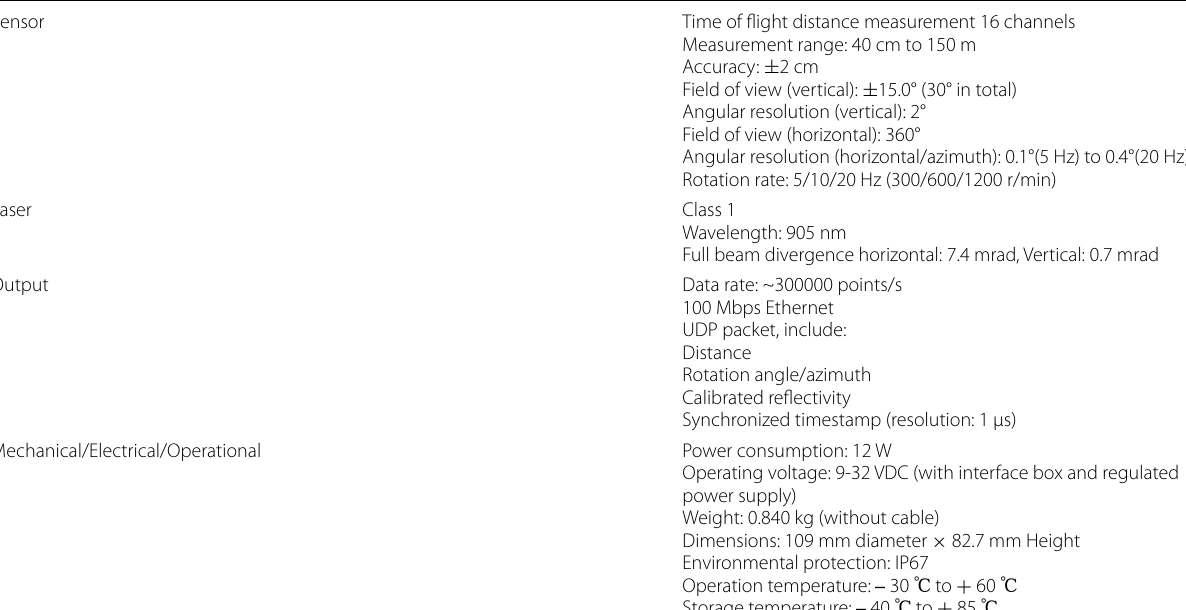
Table 2 RS-LiDAR-16 LiDAR technical parameters